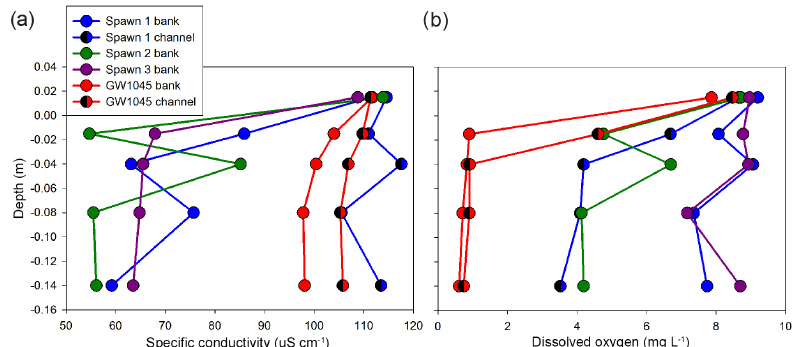
Figure 8. Minipoint pore-water chemistry data showing high spatial resolution profiles of (a) specific conductance and (b) dissolved oxygen, collected in June 2016 at the major seepage alcoves. Triangle symbols indicate data collected farther toward the thalweg from the respective alcove bank, and all profiles include a local stream water sample taken just above the stream-bed interface.